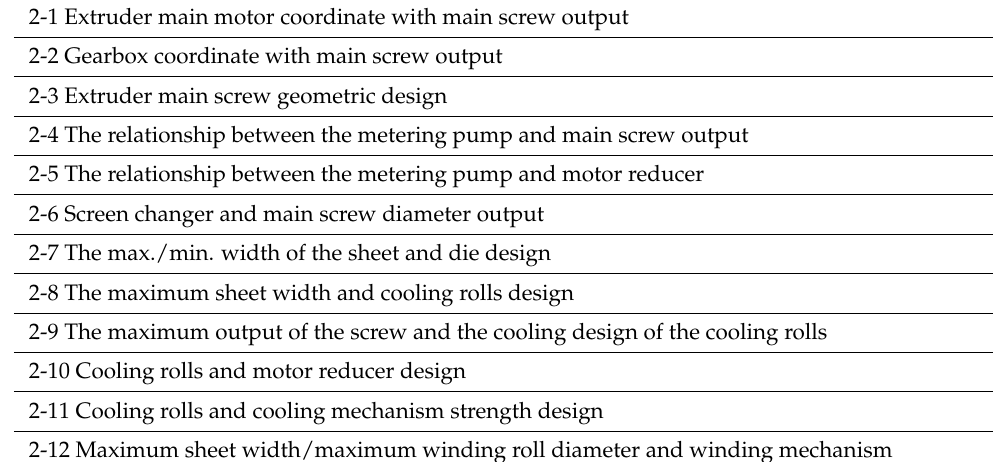
Table 3. Key factors of extrusion line design (12 subitems).